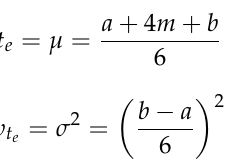
Figure 4. Fault tree analysis of Placing foundation concrete tasks derived from the WBS.